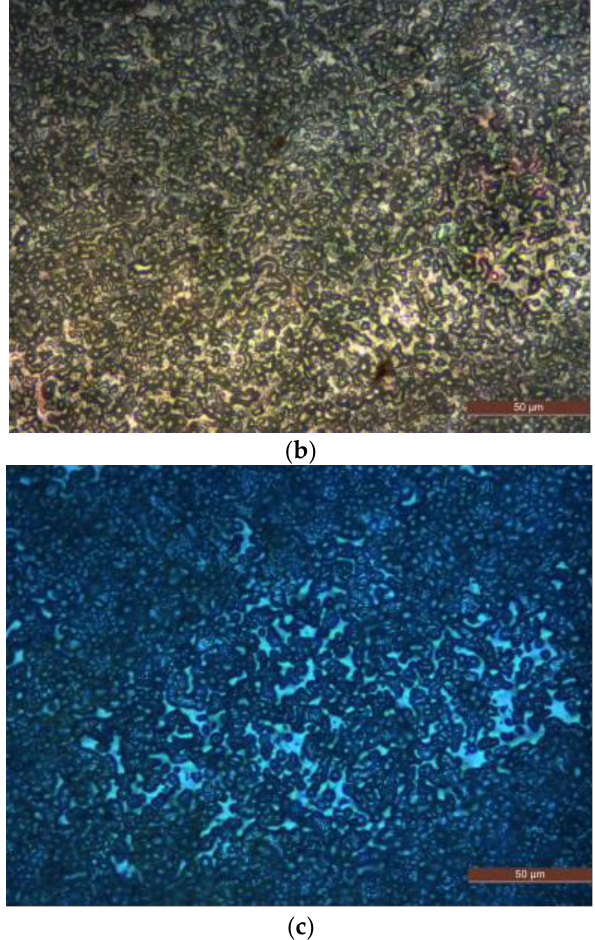
Figure 2. PLM patterns of samples P0, N5 and M5. ( a ) Crystalline morphology of sample P0. ( b ) Crystalline morphology of sample N5. ( c ) Crystalline morphology of sample M5.